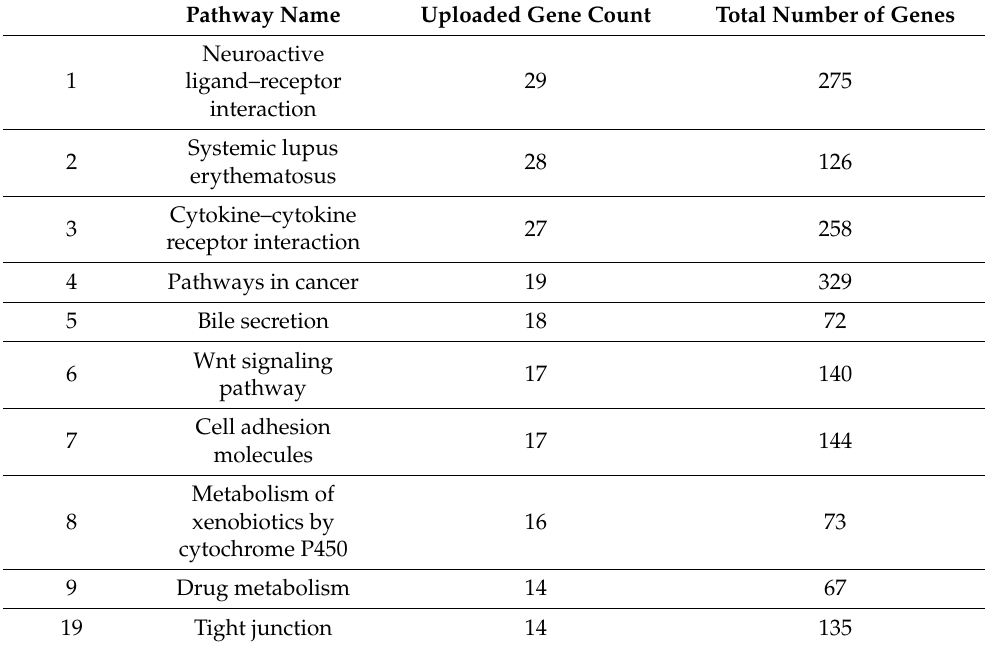
Table 2. Top 10 significant biological pathways identified for the upregulated and downregulated DEGs (|log 2 FC| ≥ 2.50) using